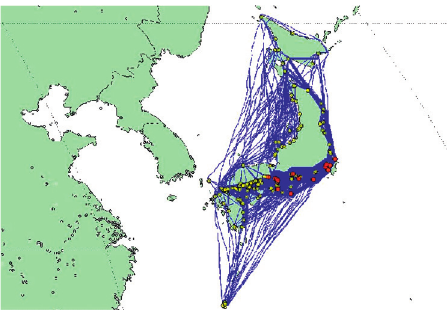
Figure 7: The network of the domestic connections among Japanese